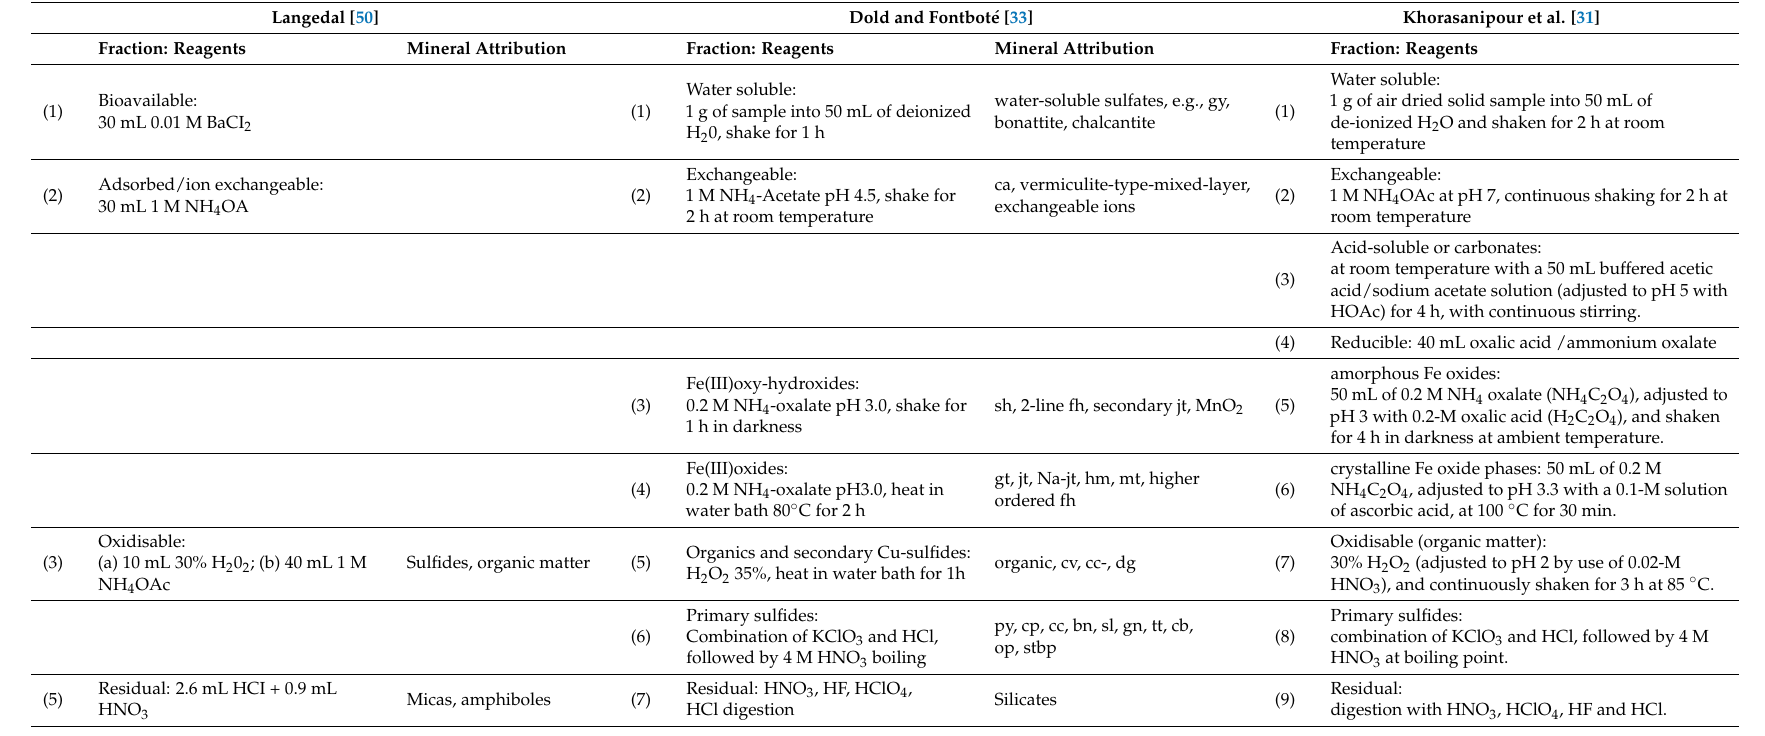
Table 7. Sequential extraction schemes for Mo in mine